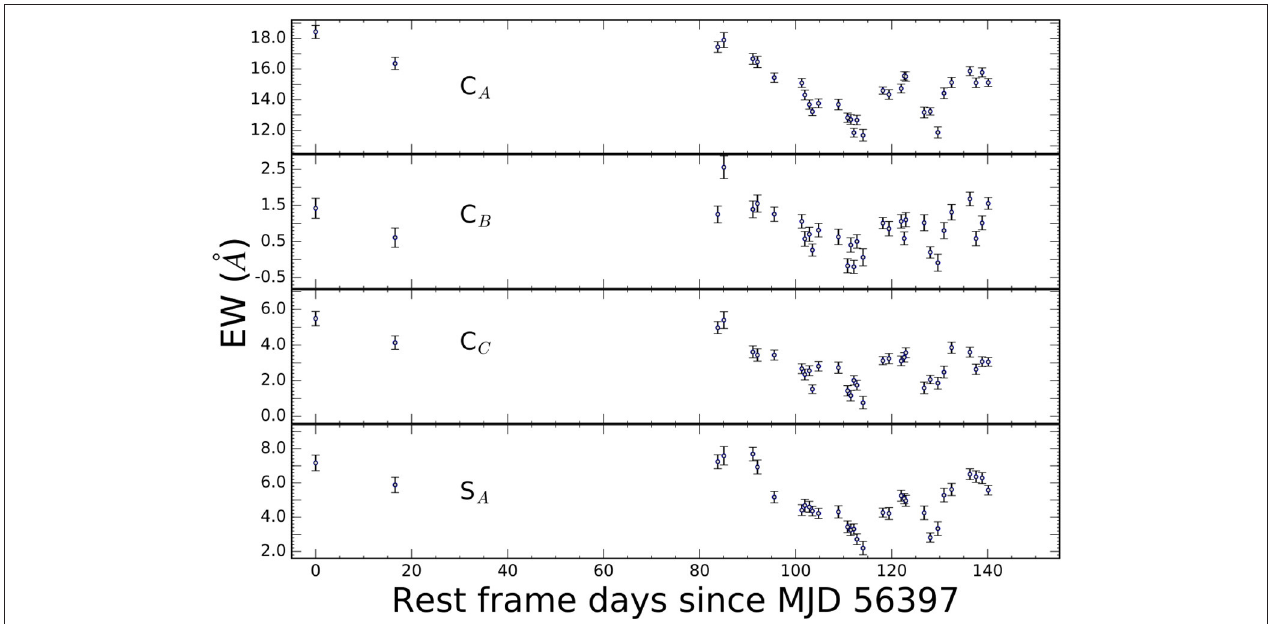
FIGURE 3 | Time dependent EW variations, respectively from top to bottom, for C IV troughs A, B, and C and Si IV trough. BAL EW variations of individual troughs have strong significant